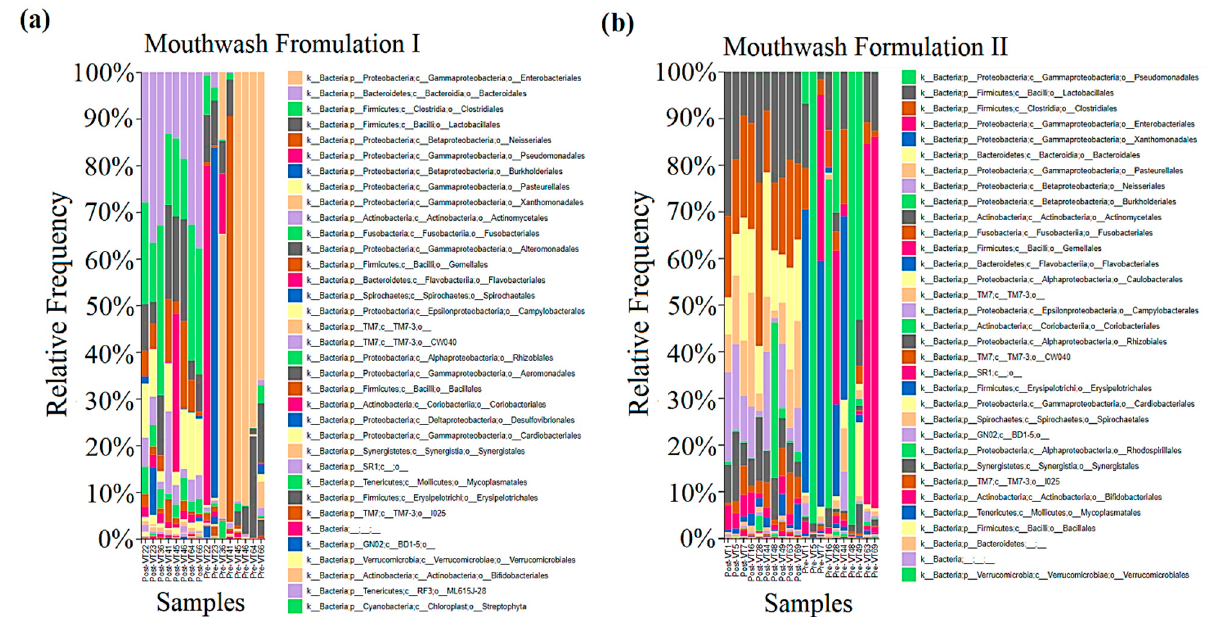
Figure 3. Taxonomy was assigned to the samples (pre-and post-treatment) collected from G1 ( a ) and G2 ( b ), and its relative frequency was compared.